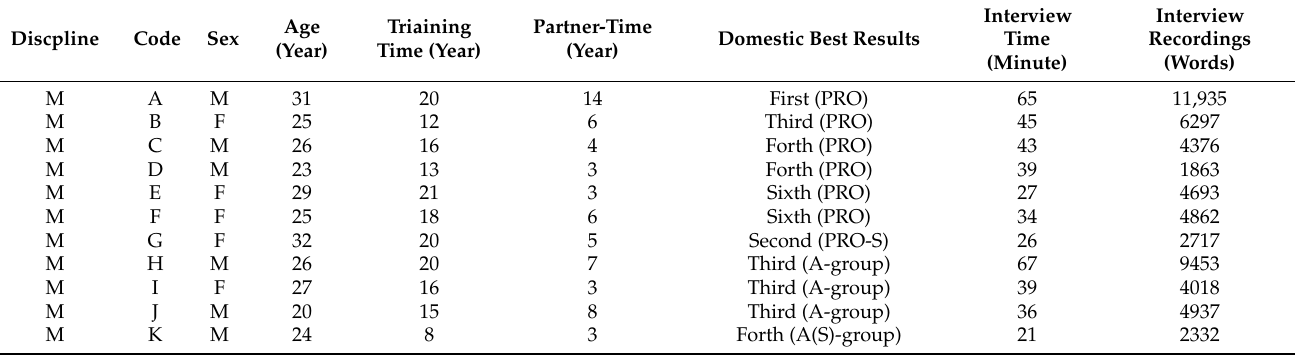
Table 1. Basic information of interviewed